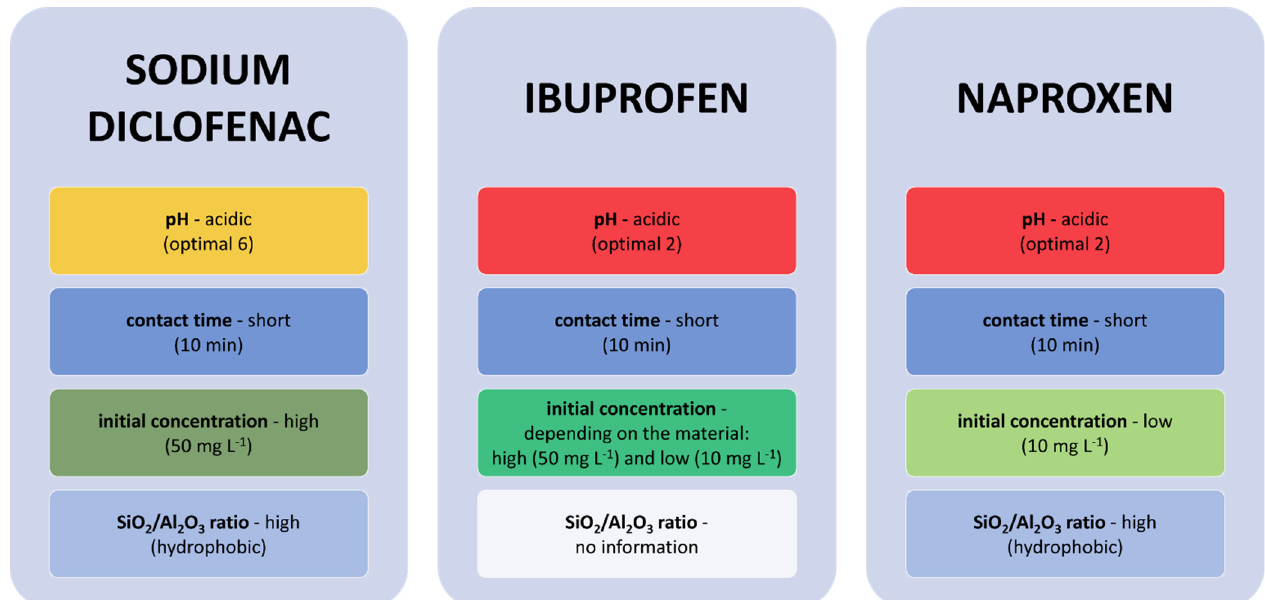
Figure 4. Factors influencing the removal efficiency of selected zeolites: sodium diclofenac—ZSM-5, hierarchical ZSM-5, natural Jordanian zeolite (intermediate silica), TMOR18, TMOR240, MNCZ; ibuprofen—natural Jordanian zeolite (intermediate silica), MNCZ; naproxen—MNCZ, ZSM-5, MOR200. Table 6. Parameters of zeolites for the removal of selected NSAIDs (diclofenac, ibuprofen, and naproxen) and selected antibiotics (erythromycin, sulfamethoxazole, tetracycline, and trimethoprim). Adsorbate